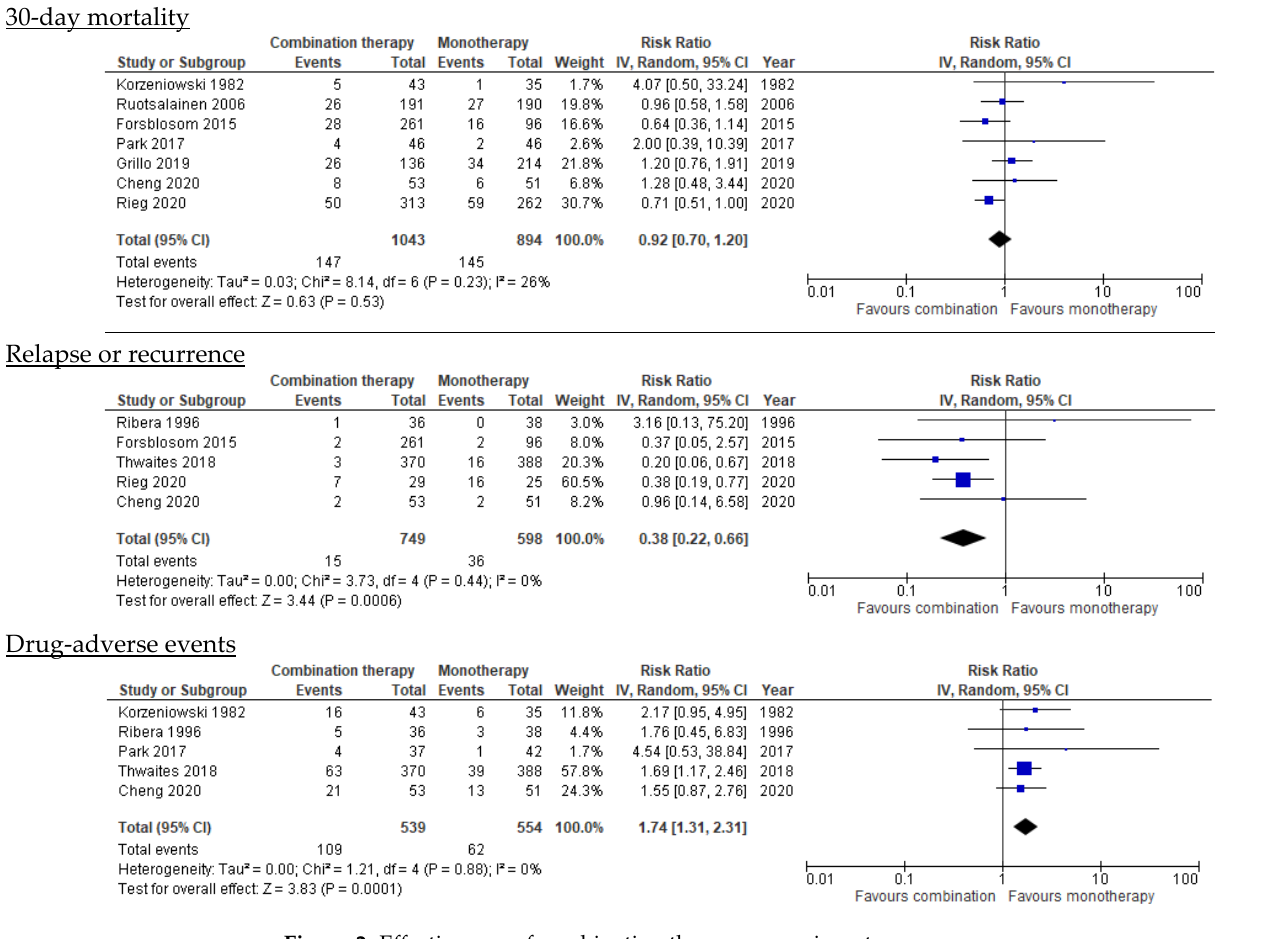
patients with native valve endocarditis, in particular right-sided endocarditis (30–100%